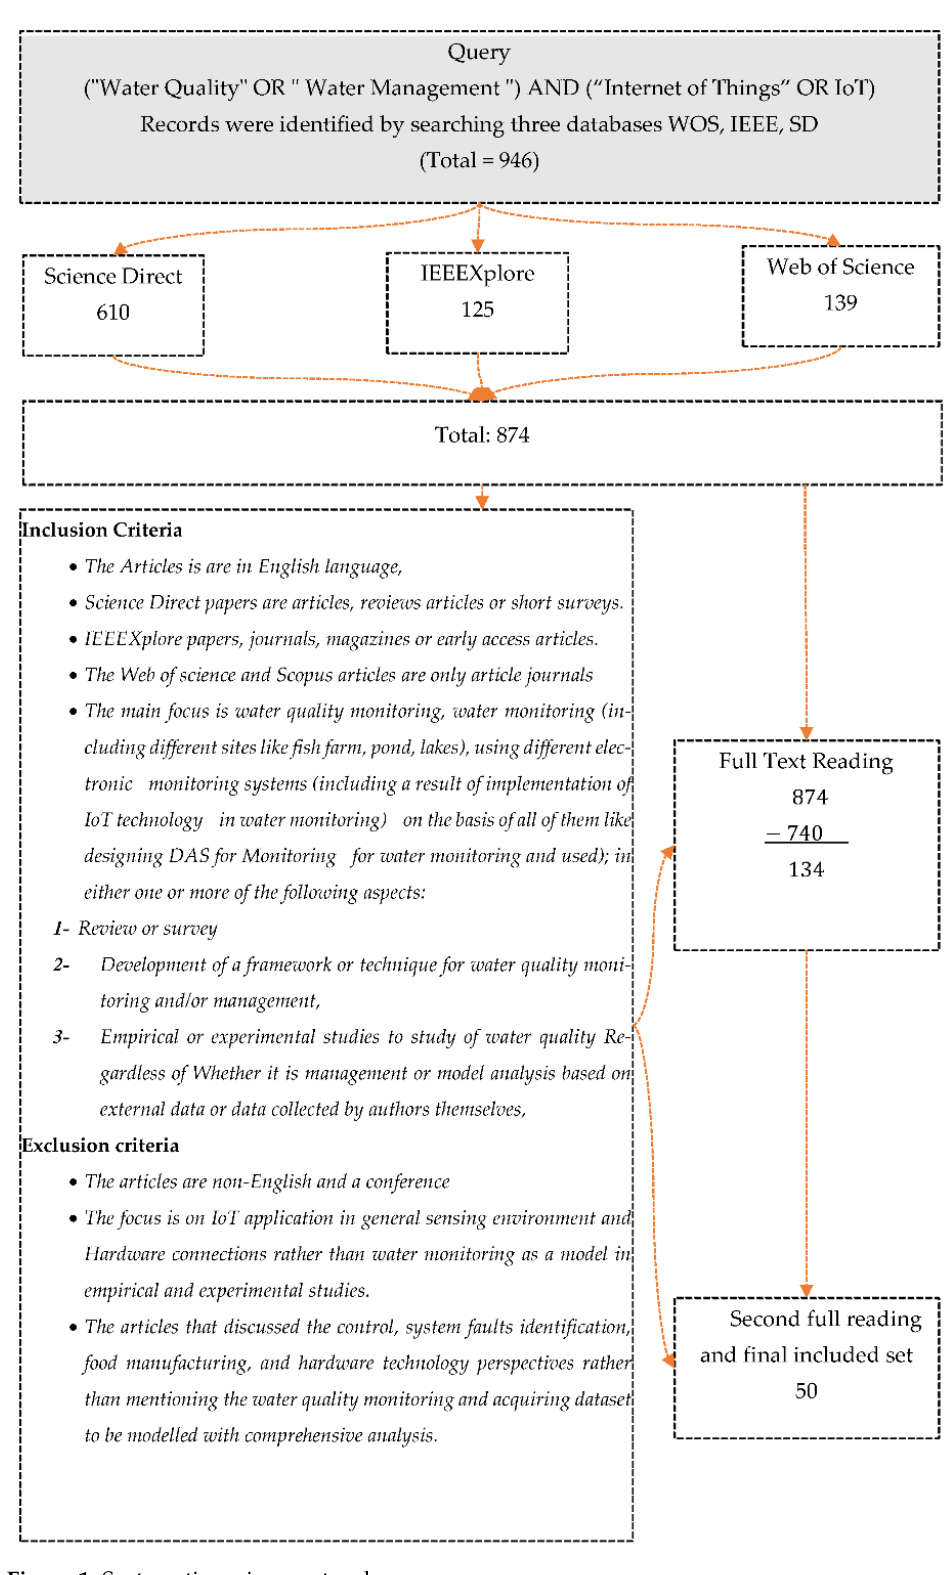
Figure 1. systematic review